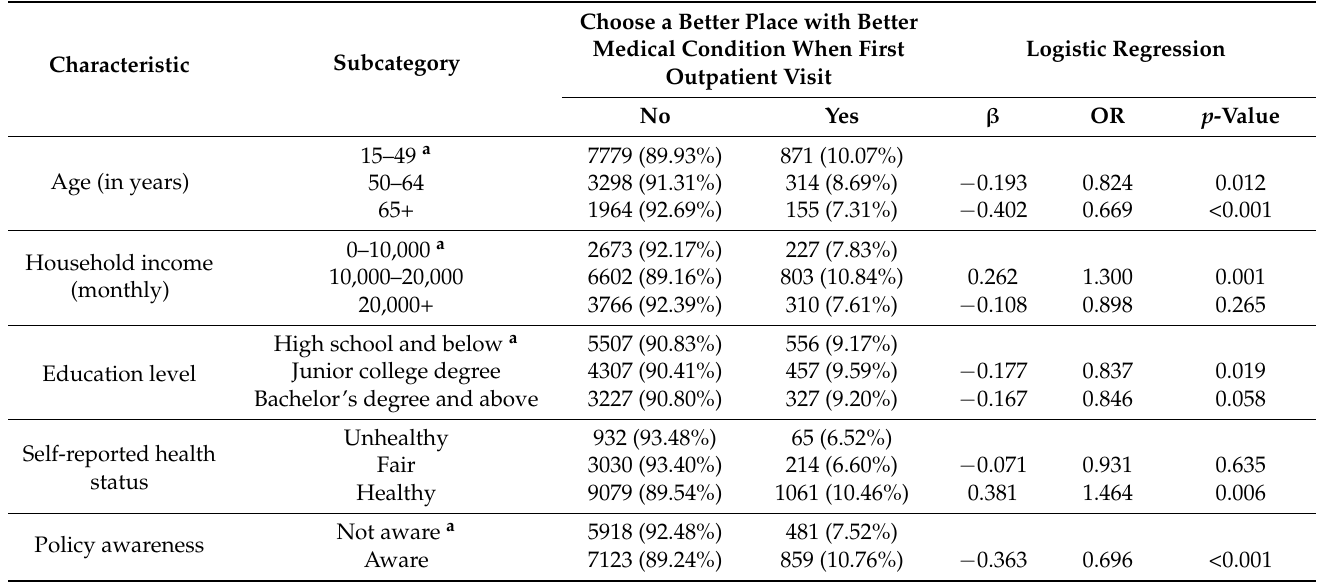
Table 4. Factor analysis on choice of first consultation place under the